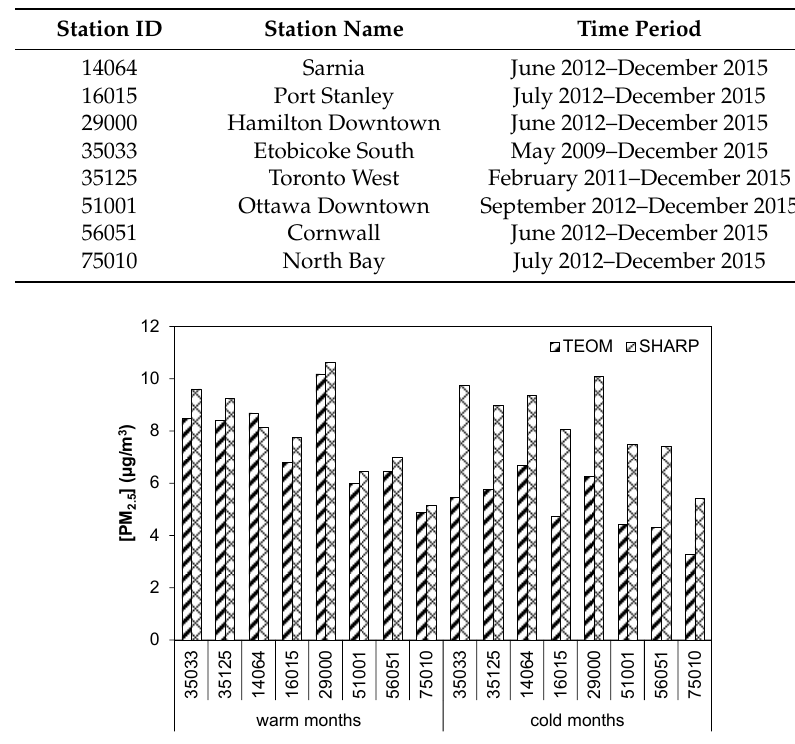
Table 4. Sampling time periods of collocated SHARP 5030 and Tapered Element Oscillating Microbalance (TEOM) monitors at eight select stations.